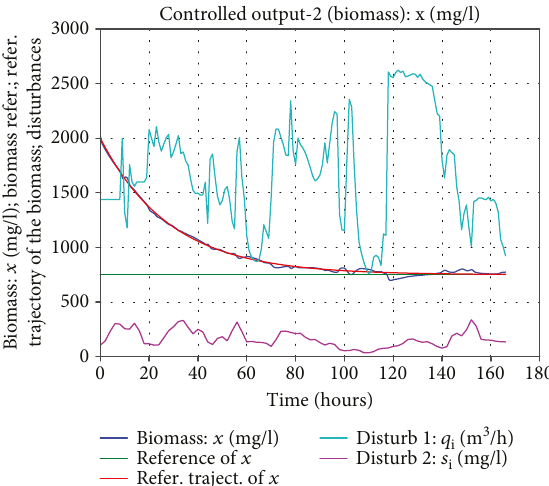
Figure 14: Biomass in the reactor and disturbances (case A).